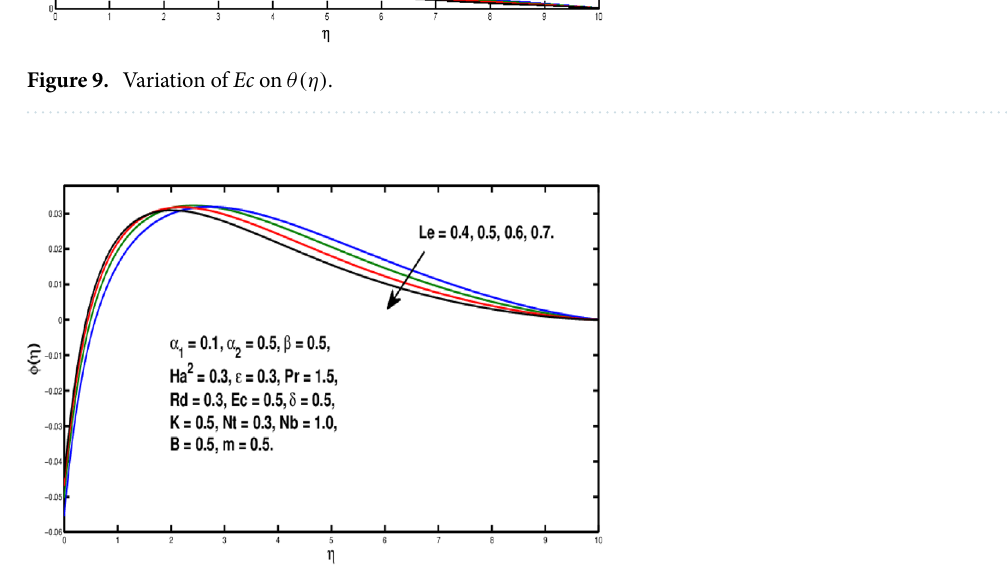
Figure 10. Variation of Le on φ(η)